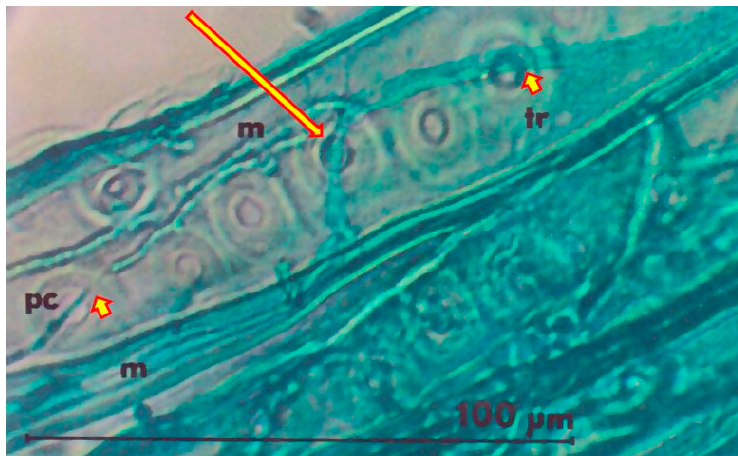
Figure 5. Phlebiopsis gigantea hyphae penetrating pine sapwood (cross-section: m = mycelium, tr = tracheid, pc = pit cells; arrows indicate hyphae) (Sierota [64]). Different P. gigantea isolates show not only different rates of growth of mycelium on agar media